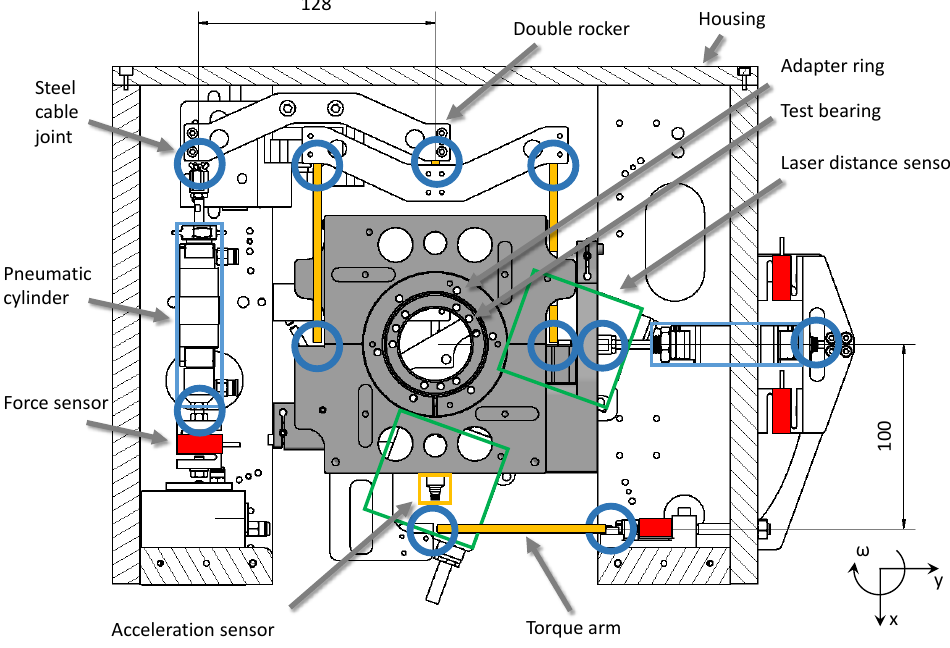
Figure 5. Enhanced lift-off test rig used in this